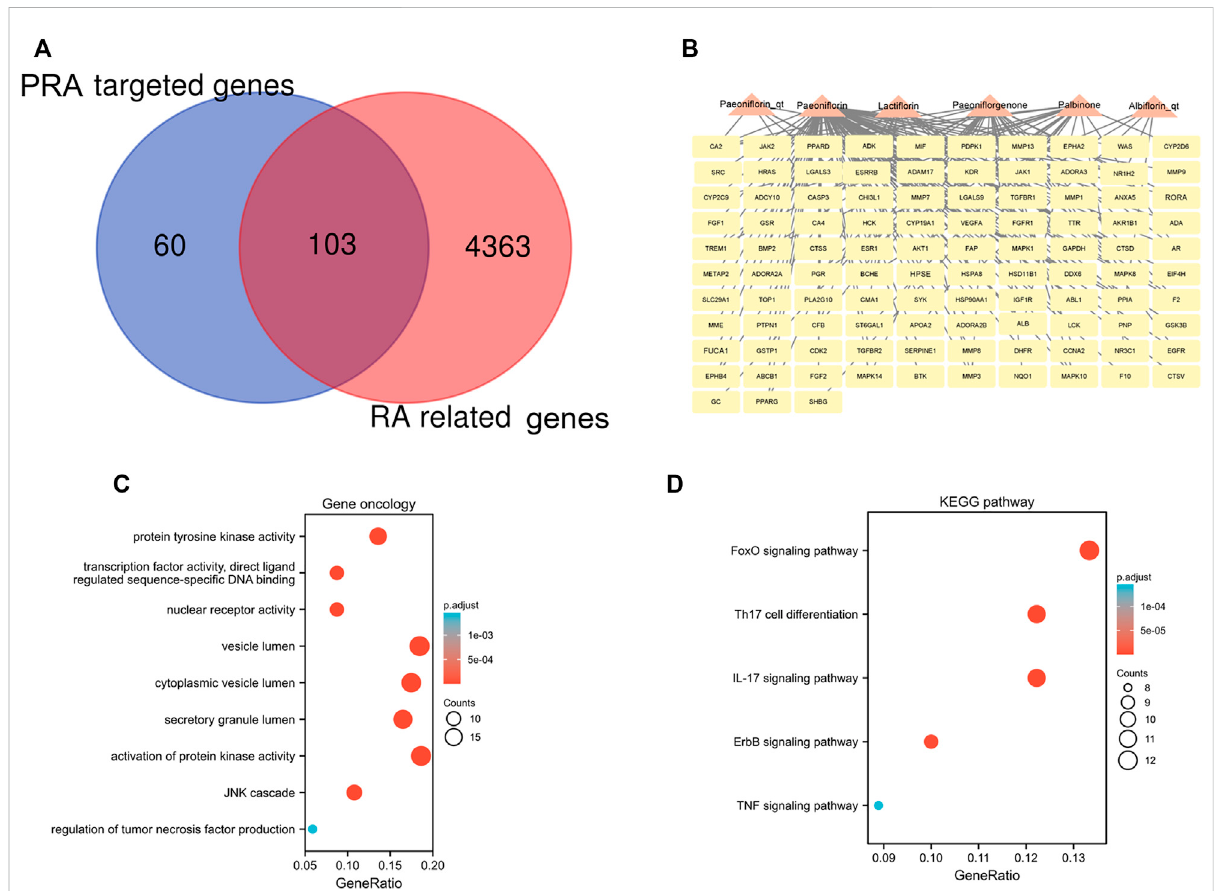
FIGURE 3 103intersectedgenesbetween Paeoniae RadixAlba (PRA)andrheumatoidarthritis(RA)andthefunctionalenrichmentofthesegenes. (A) Venn diagramofgenesbetweenRAandPRA; (B) 103predictedtargetgenesofPRA(Palbinone,paeoni fl orin_qt,albi fl orin_qt,paeoni fl orgenone,lacti fl orin, and paeoni fl orin); The enrichment analysis results of (C) GO and (D) KEGG pathway. Adjusted p value < 0.05 was considered signi fi